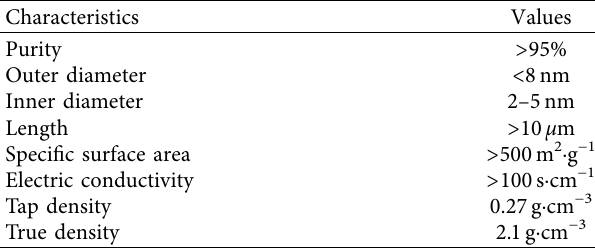
Table 1: Specifications of MWCNTs used in this